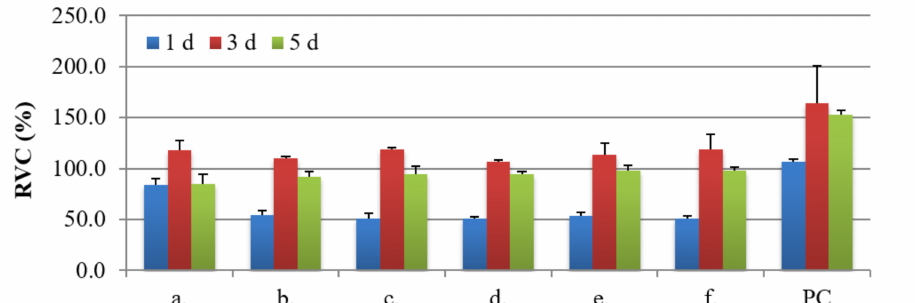
Figure 10. The results of the MTS assays performed at 1, 3, and 5 days on the viability of the fibroblasts for: Ti31Mo ( a ), Ti31Mo after hydrothermal treatment ( b ), Ti31Mo5HA ( c ), Ti31Mo5HA1Ag ( d ), Ti31Mo5HA2CeO 2 ( e ), Ti31Mo5HA2Ta 2 O 5 ( f ); PC—positive